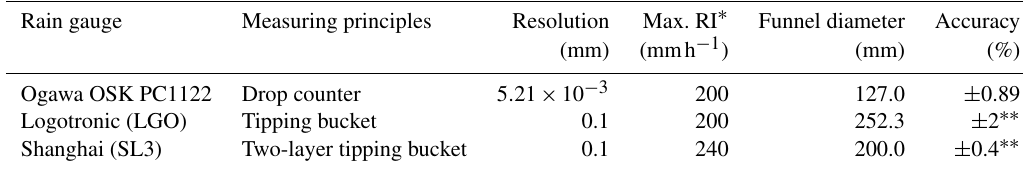
Table 1. Types of rain gauges employed for this comparison and their principal characteristics.